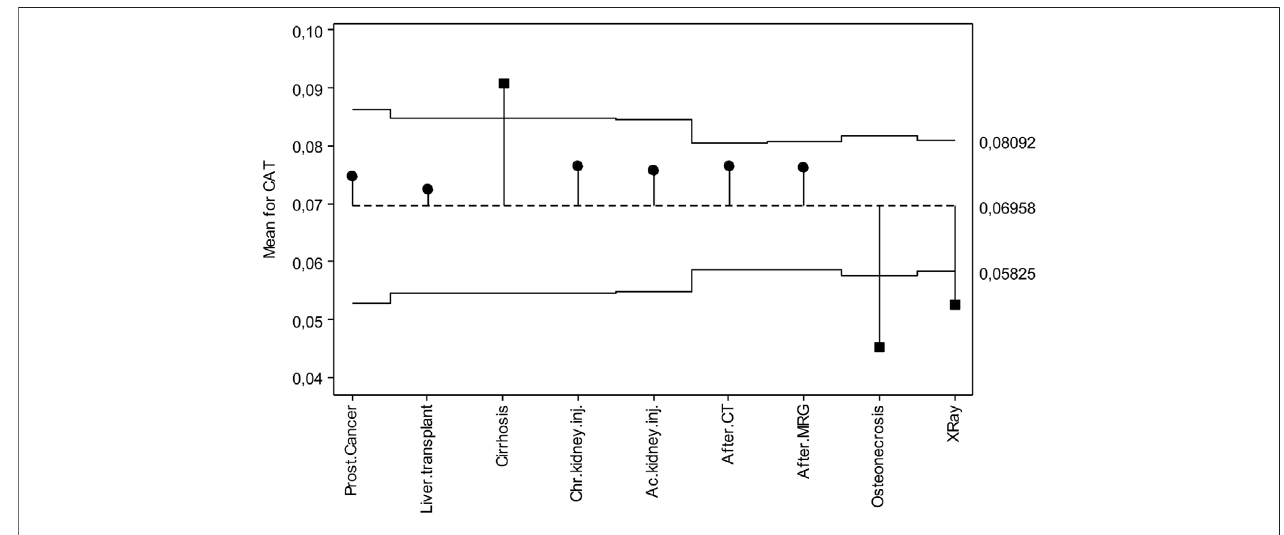
FIGURE 3 | ANOM diagram for CAT levels.